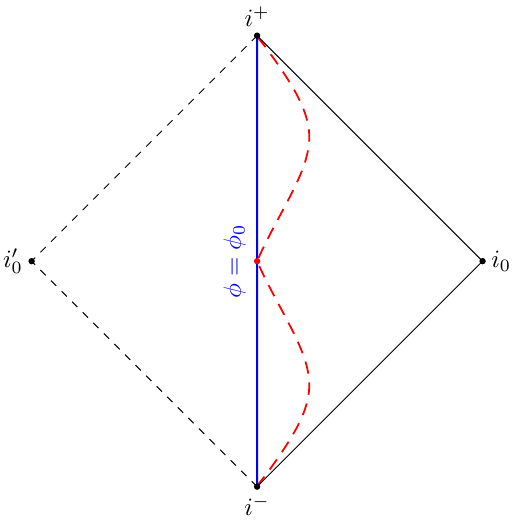
Figure 1 . Penrose diagram for the vacuum solution in the CGHS model. The boundary (cid:30) = (cid:30) cuts o(cid:11) the strongly coupled region to the left making the model semiclassically tractable. Dashed line shows the trajectory of a particle re(cid:13)ecting o(cid:11) the